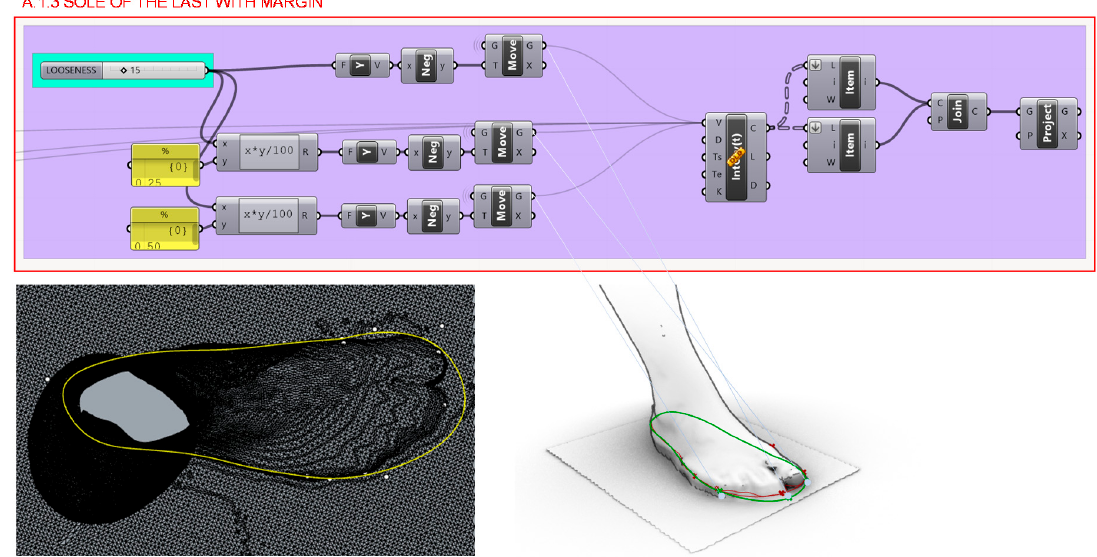
Figure 8. Programming structure definition to generate the sole of the last with margin.